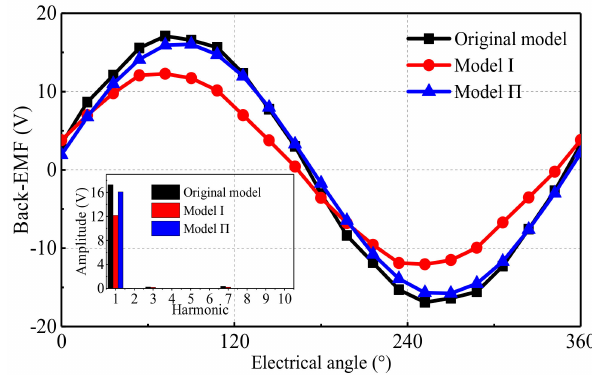
Figure 17. Back-EMF